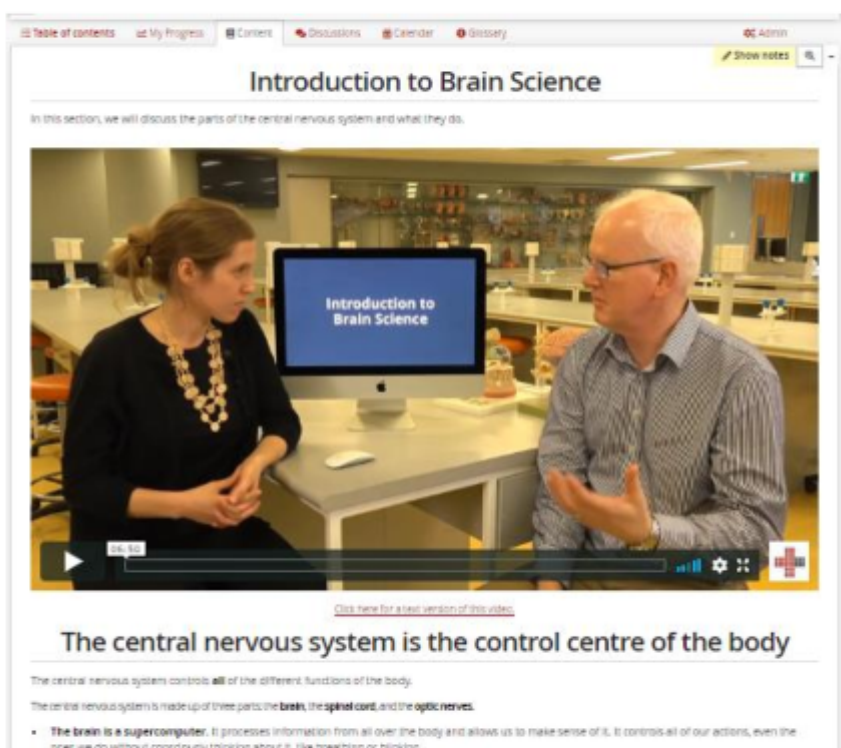
Figure 3. Screen capture showing the layout of a single page of the